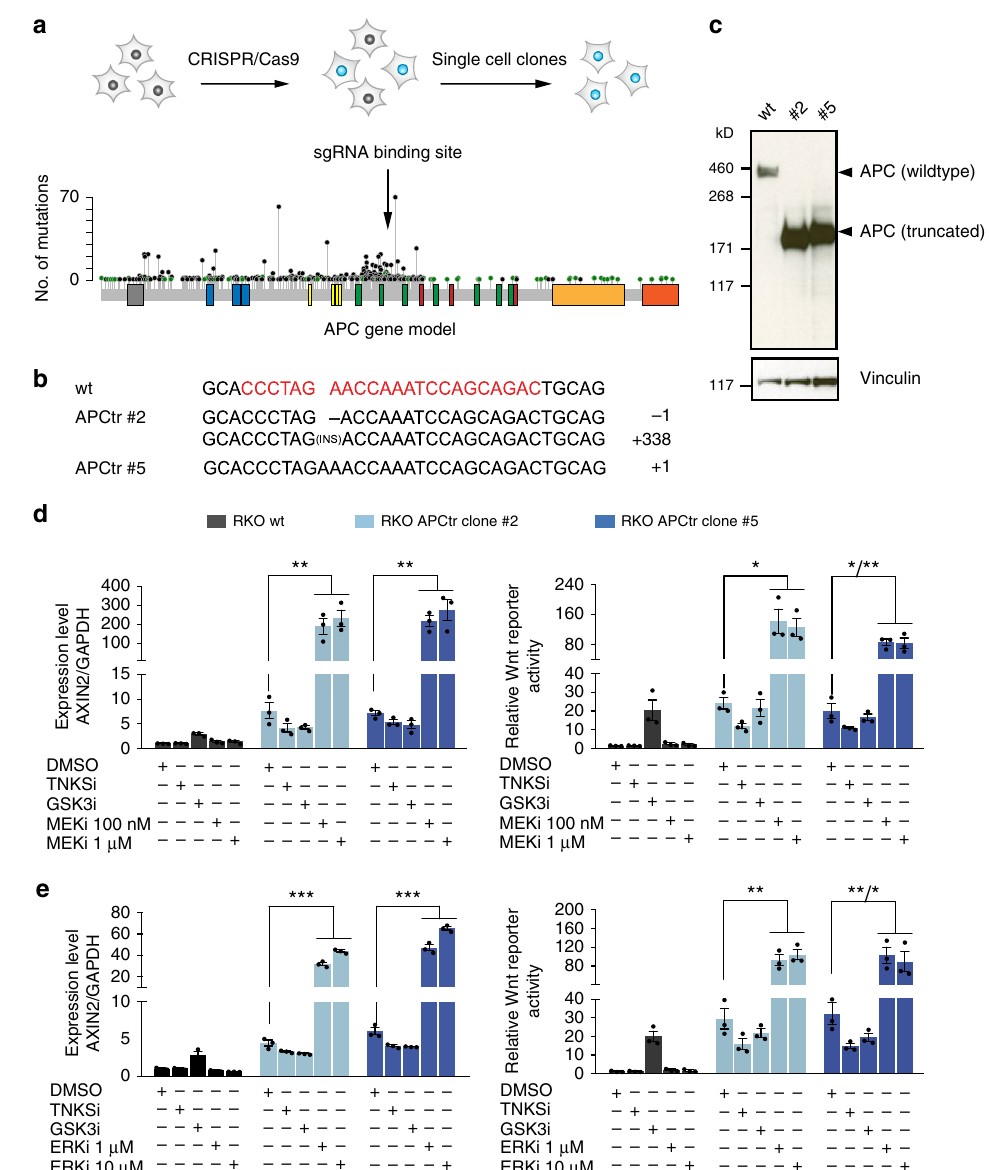
Fig. 4 Synergistic effect of APC truncation and Ras pathway inhibition on Wnt activity. a – c Gene editing of APC truncations in RKO cells using CRISPR/ Cas9. RKO cells harbouring wild-type APC were used for gene editing. A single sgRNA targeting the frequently mutated CTNNB1 binding region of APC was cloned into the px459 vector, which encodes both Cas9 and a sgRNA expression cassette. RKO cells were then transiently transfected with the plasmid. After antibiotic selection, single cell clones were isolated and expanded ( a ). Correct genome editing was con fi rmed by targeted amplicon sequencing of the edited gene locus ( b ) and by Western Blot of APC ( c ). d – e Wnt signalling is strongly enhanced by MEK and ERK inhibition in an APC mutant background. Wild-type and two APC truncated RKO clones (APCtr) were treated for 24 h with either trametinib (MEKi) ( d ) or GDC-0994 (ERKi) ( e ). Wnt activity was determined via the expression of target gene AXIN2 (left) and by TCF4/Wnt reporter activity (right). Data from three independent experiments are presented as mean ± s.e.m. * p < 0.05, ** p < 0.01, *** p < 0.001, two-sided Student ’ s t